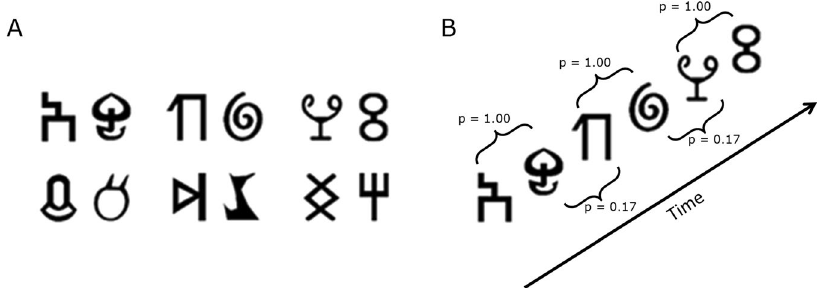
Figure 2. Schematic representation of stimuli and design. ( A ) Sample base pair structure containing randomly selected base shapes. ( B ) During the visual statistical learning familiarization phase, participants were asked to watch a stream of consecutively presented shapes. Transitional probabilities (denoted by p ) defined base pair